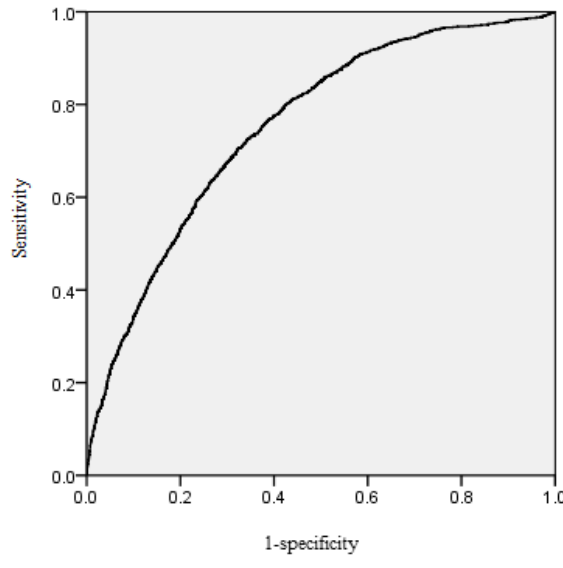
Figure 8. ROC curve of simultaneous equations for